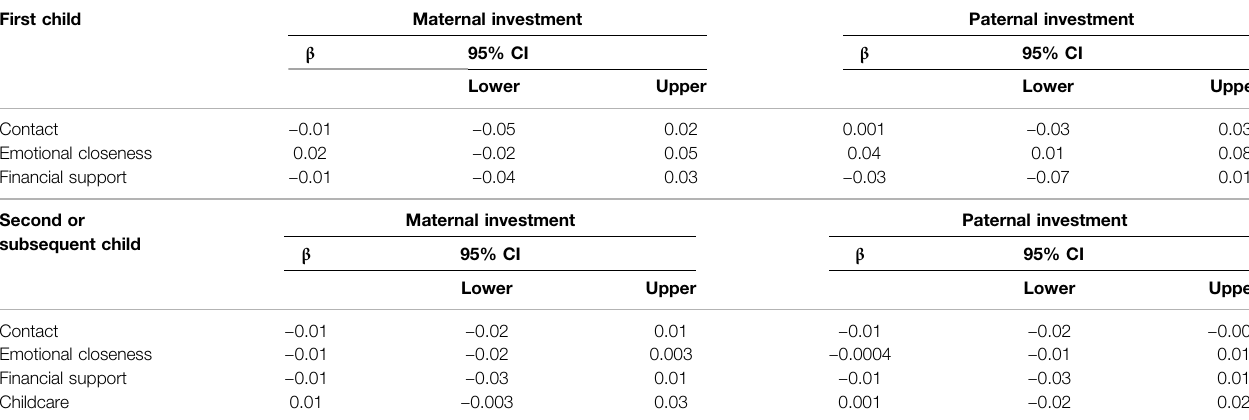
TABLE 2 | Parental investment and adult daughters ’ intentions to have a/another child over waves 1-8 in the